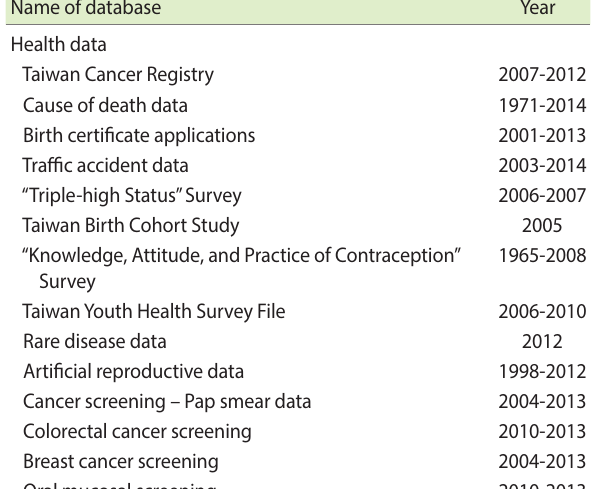
Table 2. Databases available for linkage Name of